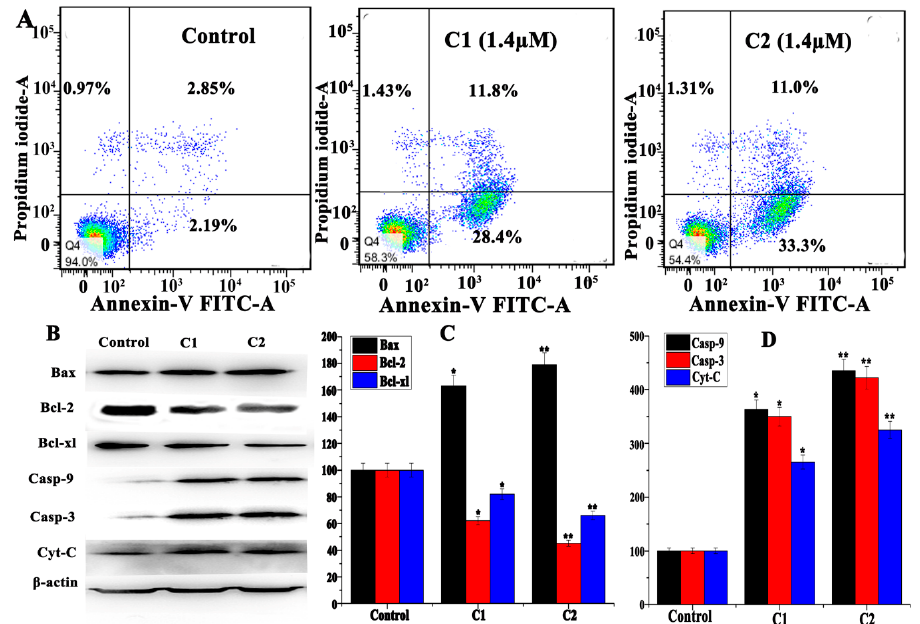
Figure 5. ( A ) Effect of cell apoptosis of A-549 cells treated with C1 (1.4 μ M) and C2 (1.4 μ M) comparing